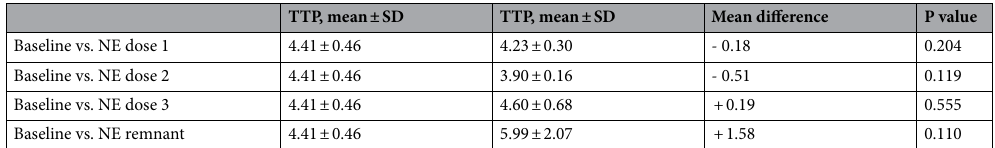
Table 3. Difference in mean TTP in seconds over increasing infusion doses. NE norepinephrine, ICGA indocyanine green angiography, TTP time-to-peak, SD standard